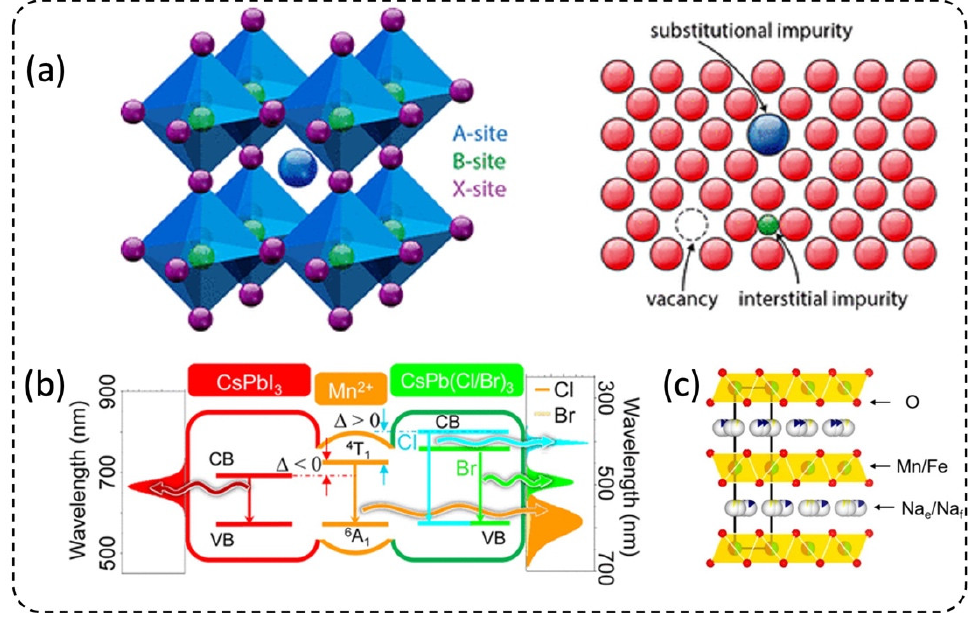
Figure 3. Structure properties of doping. ( a ) Basic ABX 3 crystal structure and possible dopant locations of perovskite semiconductor. Adapted with permission from Ref. [51]. Copyright 2021 American Chemical Society. ( b ) The energy level diagram of Mn-doped CsPbX 3 NCs. Adapted with per- mission from Ref. [16]. Copyright 2016 American Chemical Society. ( c ) Schematic of layered crystal structure. Adapted under a creative commons license from Ref. [58] (www.creativecommons.org/li- censes/by-nc-nd/4.0/ (accessed on 14 September 2022)) Copyright 2021 by the authors.